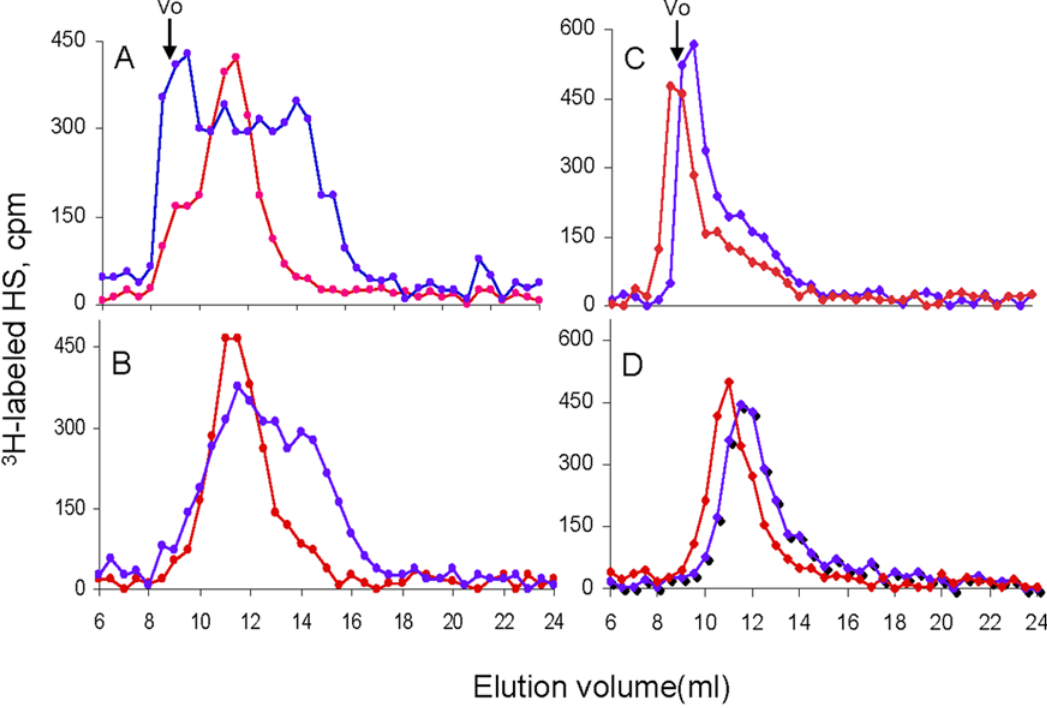
Figure 2. Molecular structure of HS from wtvs.Hpse- KO mice. Total metabolically 35 S-labeled HSPGs was isolated as described in ‘‘Materials and Methods’’. The samples were analyzed on a Superose 12 column as shown for liver (A) and kidney (C). The HSPGs were treated with alkali and the released free HS chains were analyzed on the same column as show for liver (B) and kidney (D). (Blue- wt ; red- Hpse -KO). Standard heparin is eluted at a volume of 14